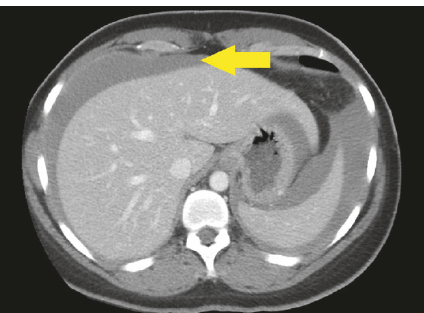
Figure2:CTofthepelviswithcontrastconcentratedinfluidaround left ovary